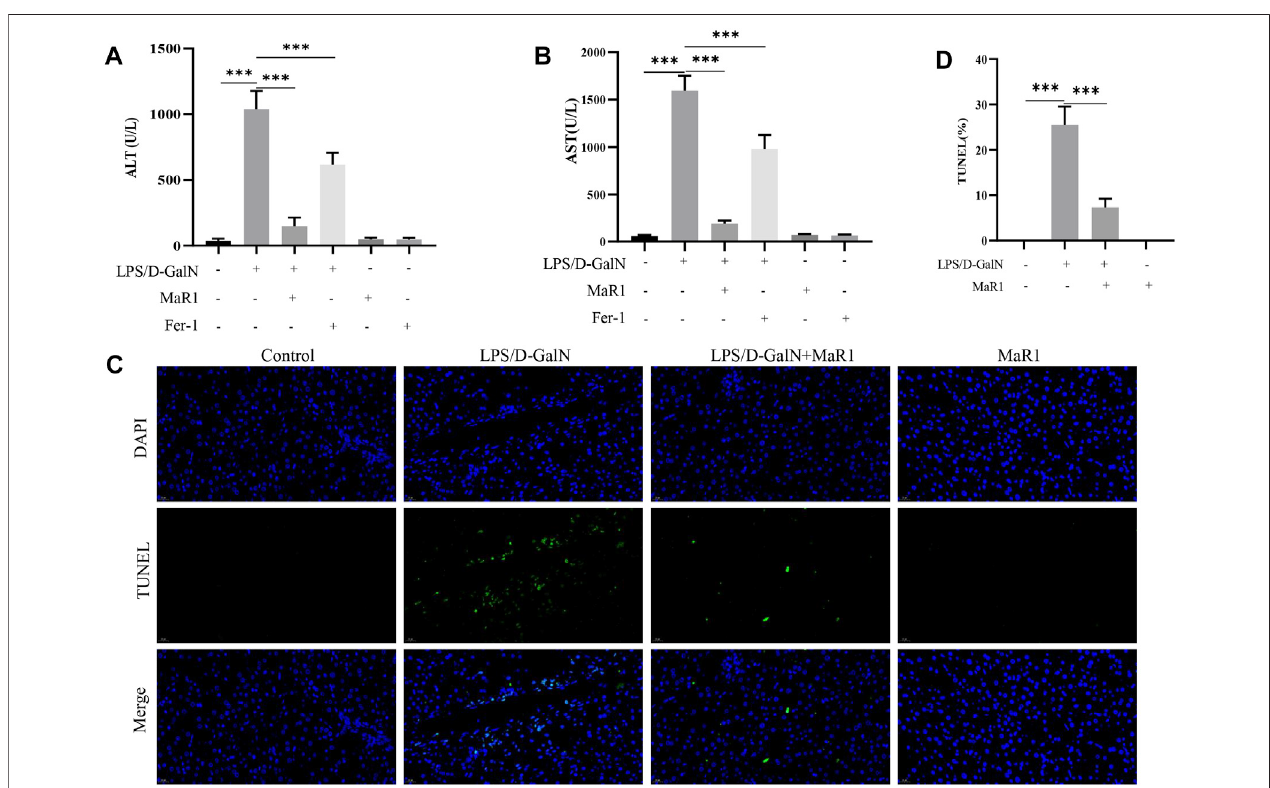
FIGURE 2 | MaR1 administration protected against liver injury and inhibited hepatocyte death. (A,B) Serum ALT and AST levels. (C,D) TUNEL assay also showed thatD-GalN/LPS promotedhepatocyte death,while MaR1inhibited hepatocyte deathcausedbyD-GalN/LPS.Dataareshownasthemean±SD,* p < 0.05;** p < 0.01; *** p <